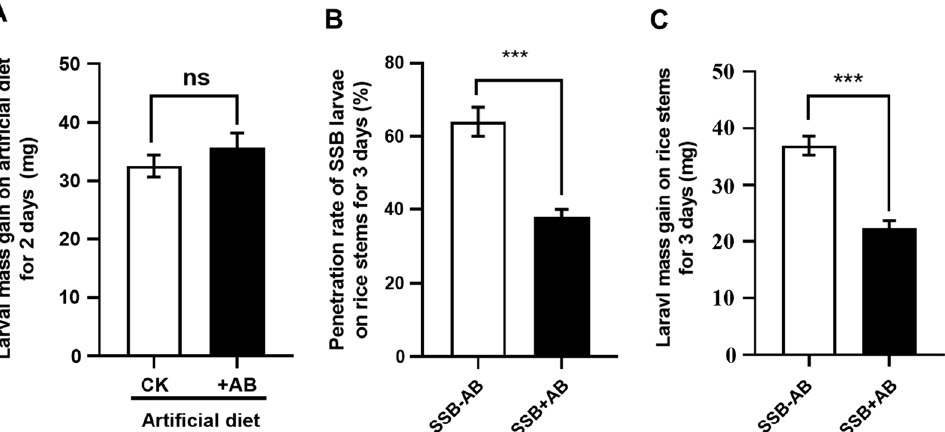
Fig. 1 Antibiotic (AB) treatment suppressed the penetration ability and growth of Chilo suppressalis (SSB) larvae on rice plants. A The mass gain of field-collected SSB larvae at 3rd instar was measured after 2 days of feeding on artificial diets with or without AB (Unpaired t -test; t 1.021, df 38, = = P 0.3137, n 20). CK, artificial diet without adding AB; AB, artificial diet contained AB. B The penetration rate of field collected SSB larvae with or = = + without AB treatment within 3 days of feeding on rice plants (Unpaired t -test; t 5.814, df 8, P 0.0004, n 5). C The mass gain of field-collected = = = = SSB larvae with or without AB treatment that had successfully bored inside rice stems (Unpaired t -test; t 6.974, df 28, P < 0.001, n 15). Values are = = = means SEM, and asterisks indicate significant differences between treatments ( n.s. , not significant; ***, P < 0.001). SSB-AB, field-collected SSB larvae ± without AB treatment; SSB AB, field-collected SSB larvae with AB +